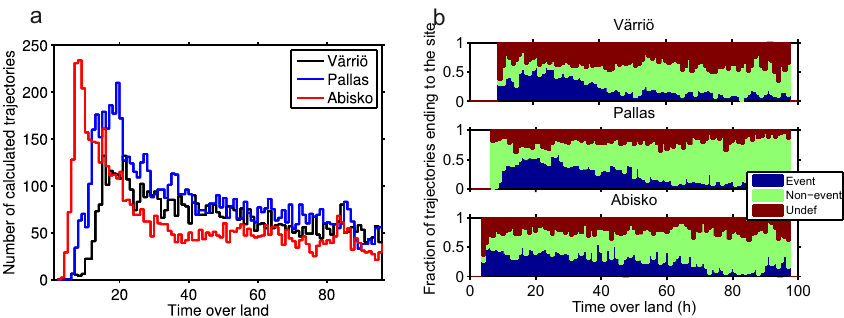
Fig. 6. (a) Distribution of the times the trajectories spent over land. (b) Fractions of the trajectories that ended at each site during event, non-event, or undefined